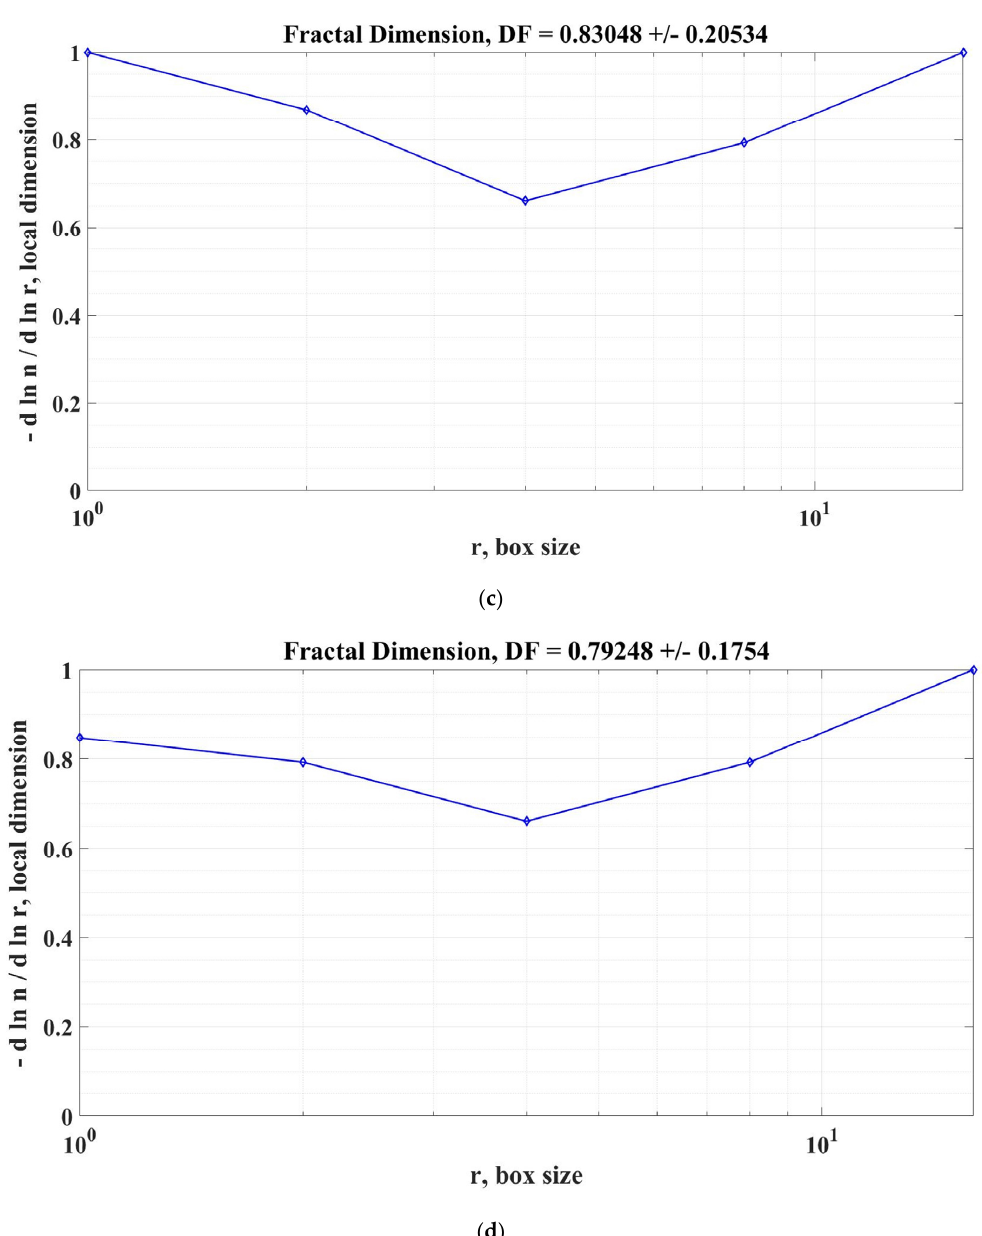
Figure 15. DF of V DC voltage signal in case of the following controller type: ( a ) PI controller with RL- TD3 agent; ( b ) TID and FO-Lead-Lag controllers; ( c ) FO-PI and PI-GWO controllers; ( d ) PI controller. Table 2. Performance indicators of the V DC voltage control for UPQC-APF control system based on the presented controllers.